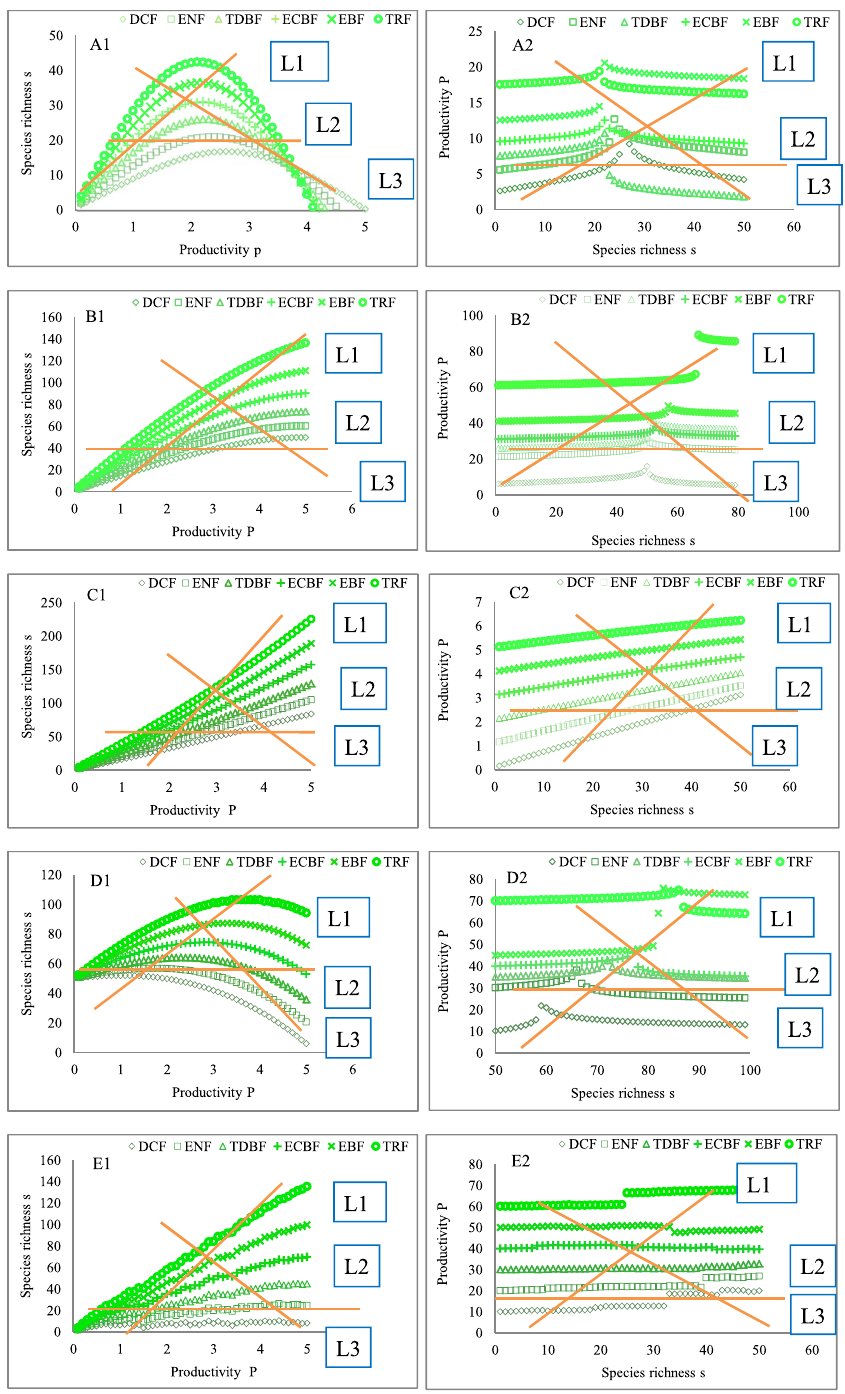
Figure 5. Relationships between the sampling methods and the forms of PSRR and SRPR. L1, L2, and L3 are the three types of sampling methods. Figs A1–E1 and A2–E2 show the five typical forms of PSRR and SRPR arising in the six zonal forests from north to south. Six of the PSRR and SRPR curves in each figure correspond to six sets of the different parameters m 1 , m 2 , a , E h , g , and k . In particular, derivation of the five types of PSRR and SRPR starts from DCF, with all parameters assigned the first value in each cell in the data columns marked with # in Supplemental Table 1. Next, successive increments of 0.03, 0.03, 0.1, 5, − 0.01, and − 0.025 are applied to the values of m 1 , m 2 , a , E h , g , and k , respectively, for the next southern forest ENF, TDBF, ECBF, EBF, and TRF. The values of the other parameters remain unchanged. After all the calculations for the forms of PSRR and SRPR using Eqs 10, 11 and 21 in each of the forests were performed, data on the same forms in the six forests were used to produce Figs A1–E1 and A2–E2. Similarly, P 0 and S 0 in a southern forest are considered to be greater than those in a northern